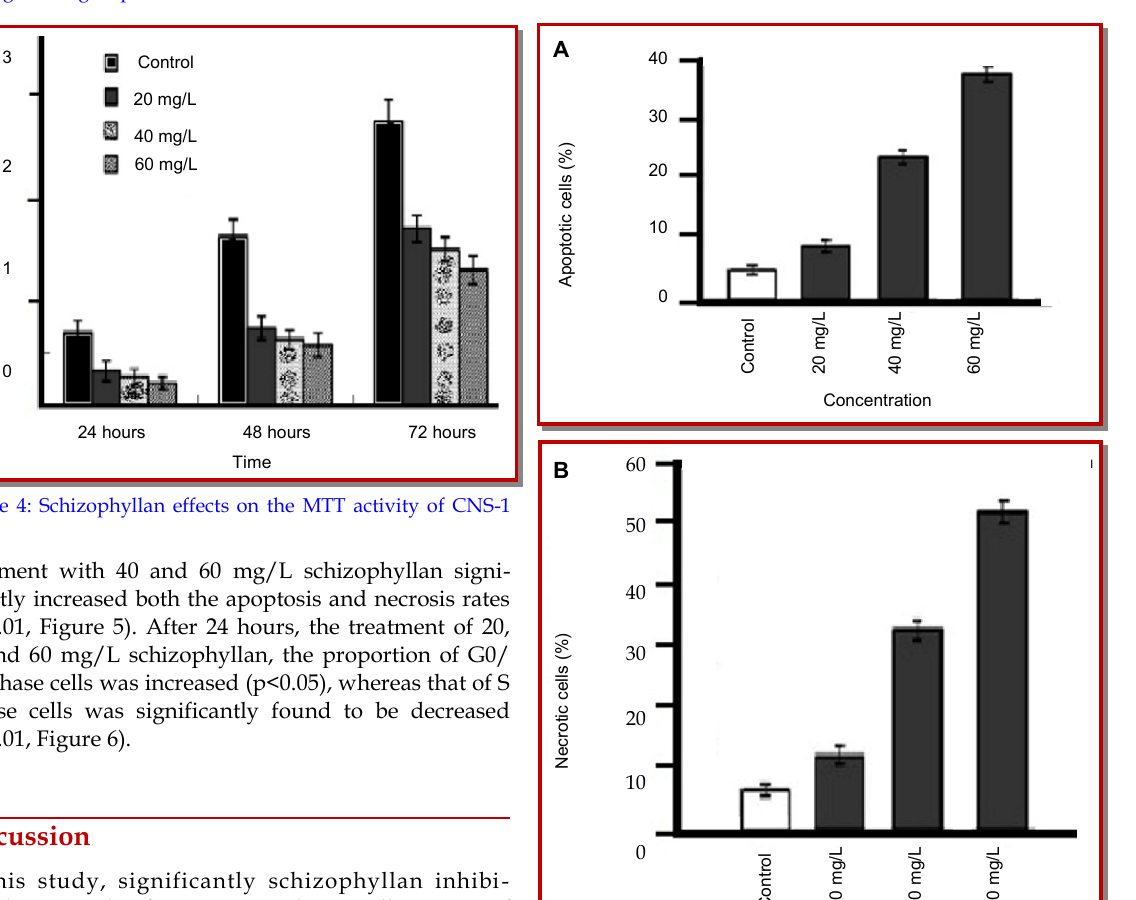
Figure 3: Schizophyllan effects on the morphology of CNS-1 cells. (A) control group; (B) low-dose group; (C) medium-dose group; (D) high-dose group